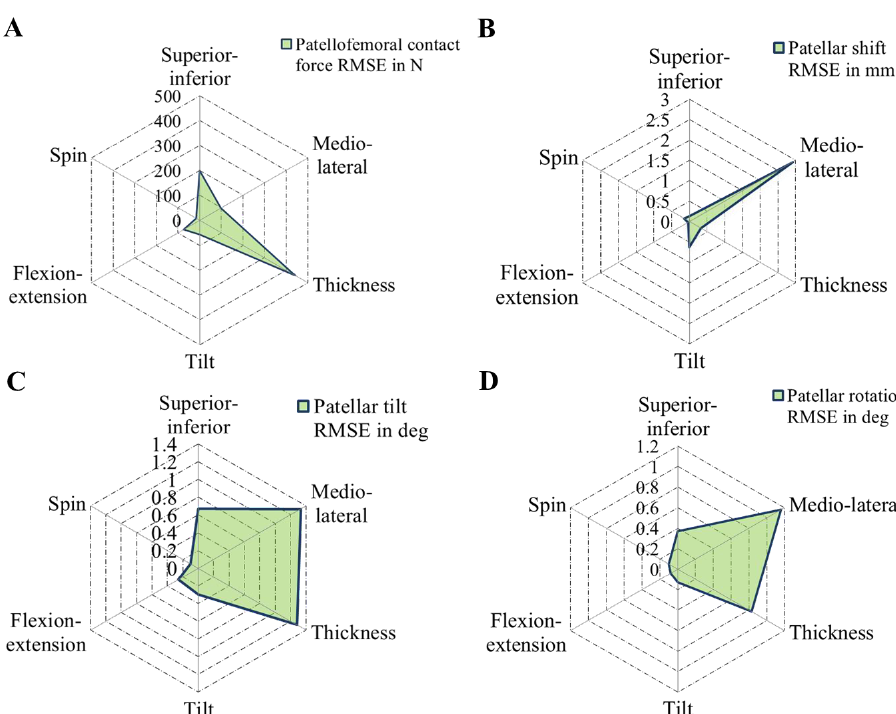
Figure 10. Radar chart representing the root-mean-square errors (RMSE) of patellofemoral contact force ( A ), patellar shift ( B ), patellar tilt ( C ), and patellar rotation ( D ) for different patellar component designs and positions: superior–inferior position, mediolateral position, patellar component thickness, tilt, flexion-extension, and spin.